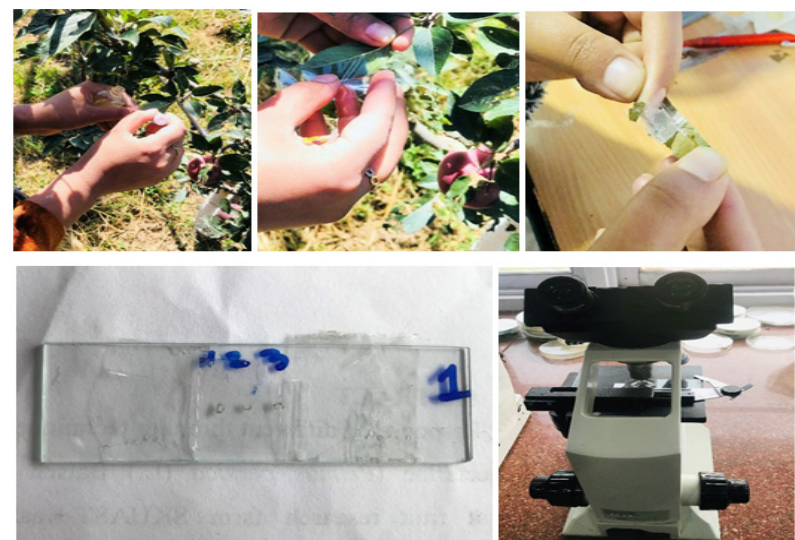
Figure 4. Stomatal studies using ocular and stage micrometer.